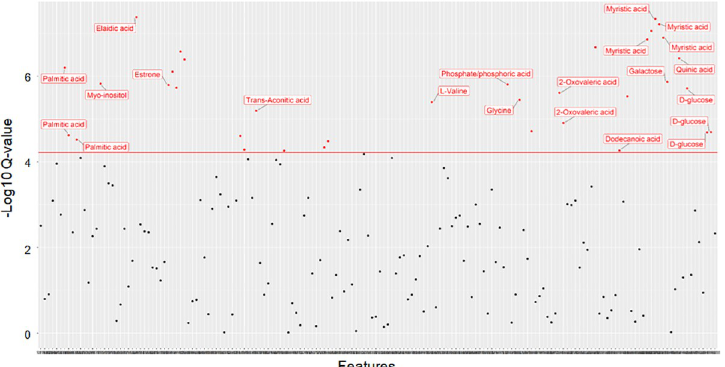
Fig 4. Association analysis of plasma GC-MS spectral data in AVS patients and control individuals. Data were derived by GC-MS analysis of plasma samples from 46 patients and 46 controls. Generalized linear models were used to determine significant associations between metabolomic peaks and AVS after adjusting for age, sex, body mass index, hyperlipidemia and diabetes, and correcting for multiple testing. Signal intensities normalized to the internal standard 2-isopropylmalic acid are plotted against the Q-values. Features showing evidence of statistically significant association with AVS (q values < 0.05) are shown with red dots.